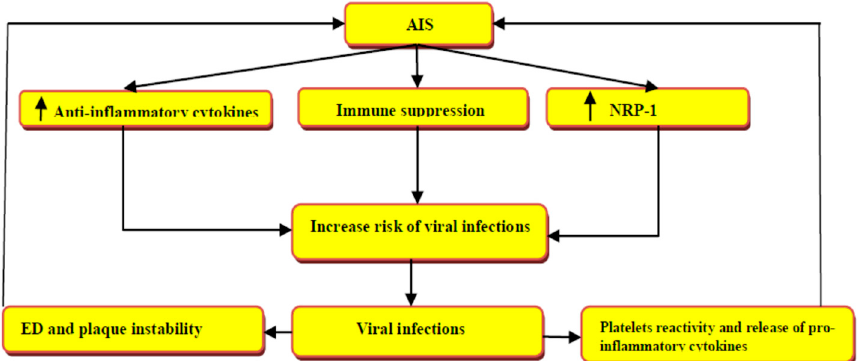
Figure 4. Viral infections and the risk of acute ischemic stroke (AIS): AIS induces the expression of neuropilin-1 receptors (NRP-1) and the release of anti-inflammatory cytokines with the development of immunosuppression. Acute viral infections lead to endothelial dysfunction (ED), plaque instability, platelets hyper-reactivity, and the release of pro-inflammatory cytokines—changes that increase the risk of AIS.